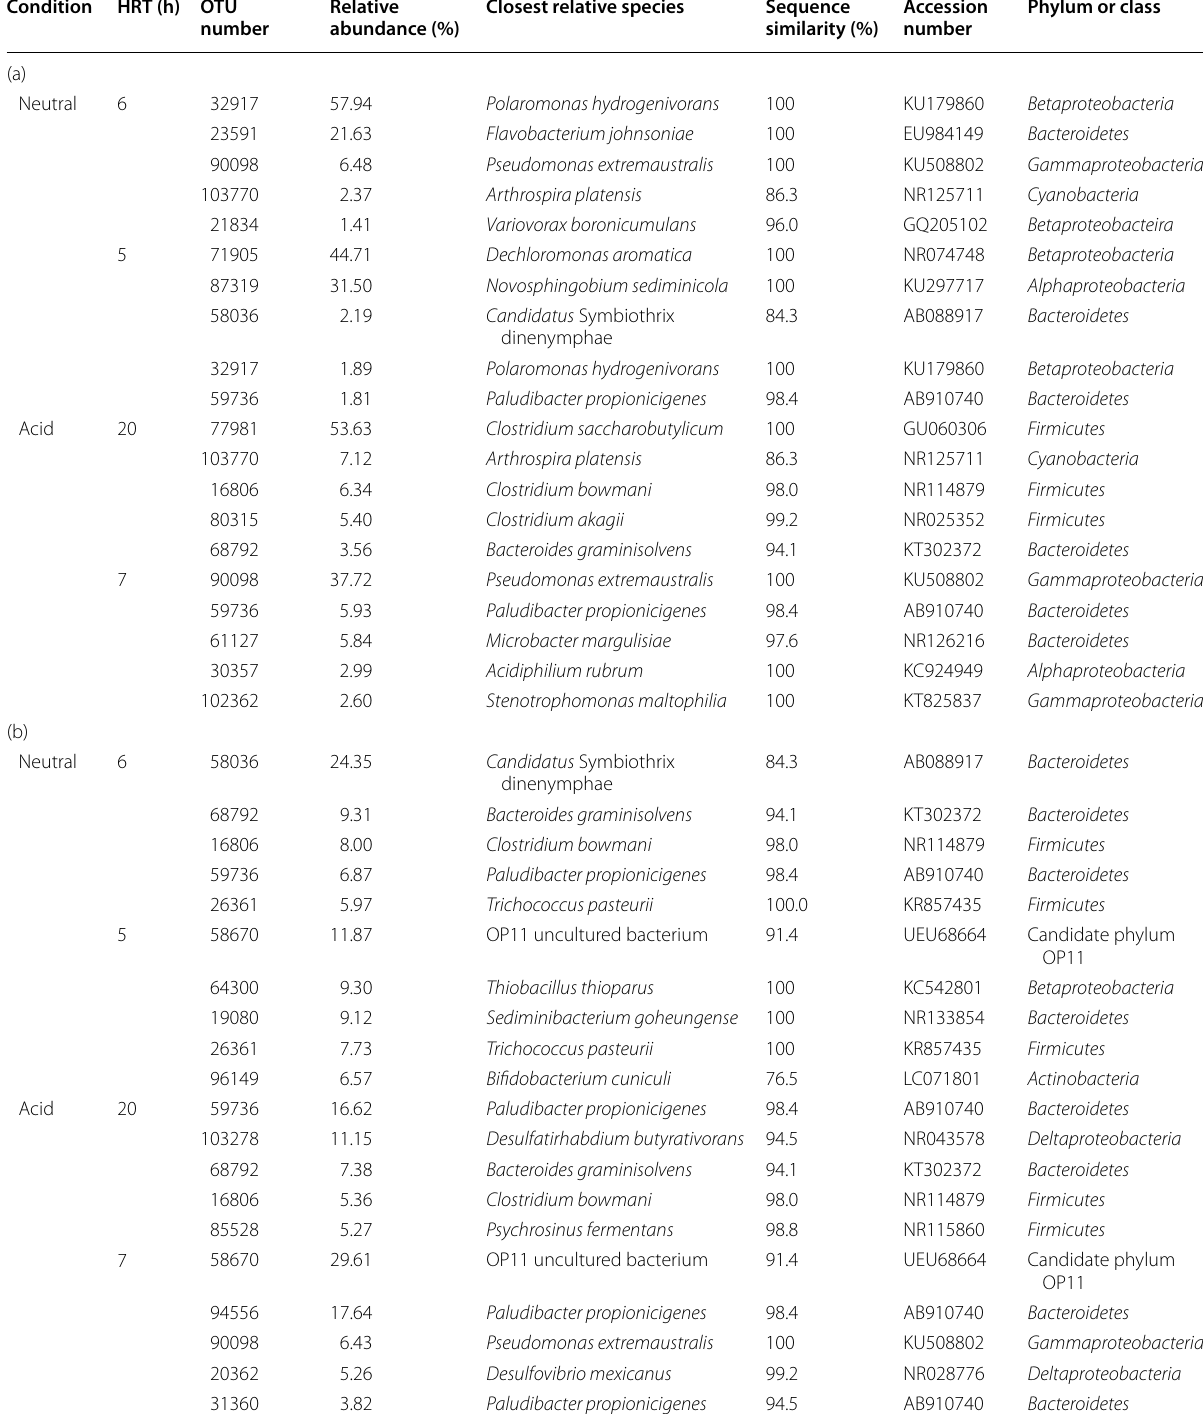
Table 2 Top 5 predominant operational taxonomic units (OTUs) at (a) the top and (b) port 4 of the reactor under the neu- tral and acid